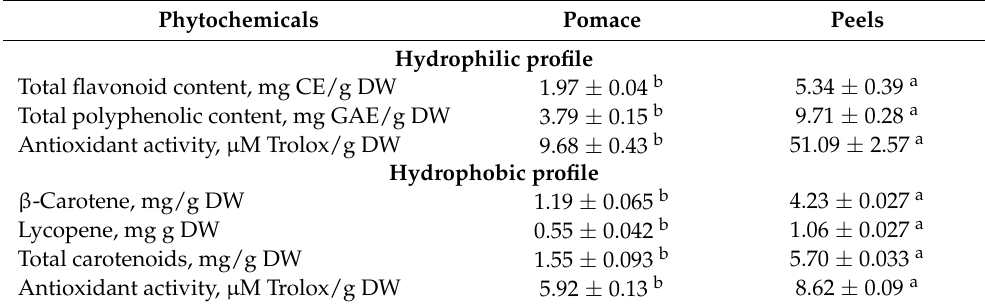
Table 1. Phytochemical characterization and antioxidant activity of kiwifruit pomace and peels. Phytochemicals Pomace Peels Hydrophilic profile Total flavonoid content, mg CE/g DW Antioxidant activity, µ M Trolox/g DW β -Carotene, mg/g